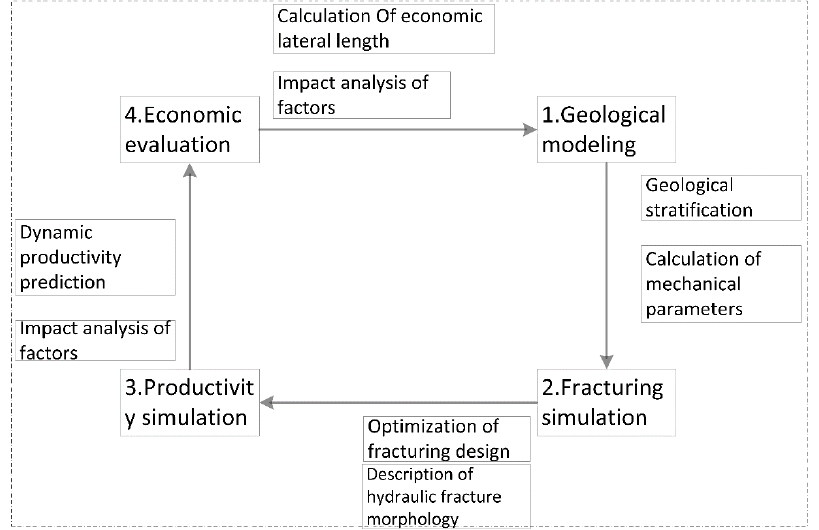
Figure 1. Flow chart detailing the process for the optimization of the lateral length of shale-gas horizontal well based on geology – engineering – economy integration.